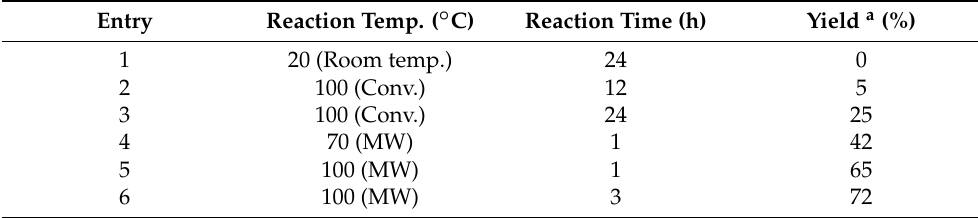
Table 1. The reaction of benzoyl benzotriazolide with metformin in presence of TEA in